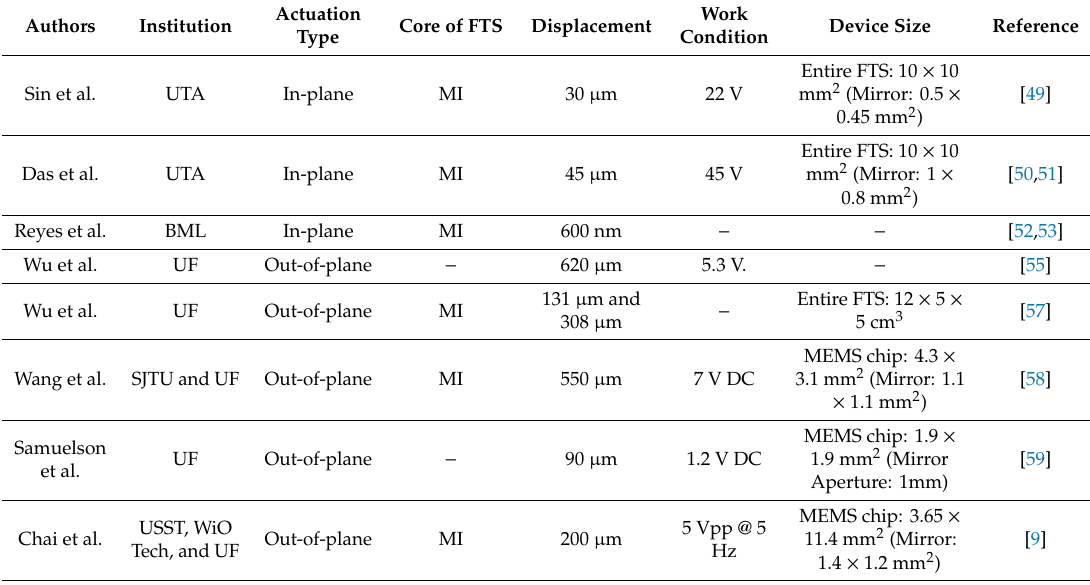
Table 3. Comparison of electrothermal MEMS micromirrors and FTS.